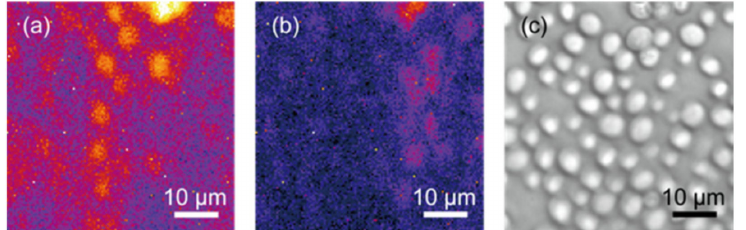
Figure 5. Water-immersed living yeast cells autofluorescence images on the aluminum thin film ( a ) with deep-UV SPR of p -polarization, ( b ) without deep-UV SPR of s -polarization and ( c ) conven- tional reflection